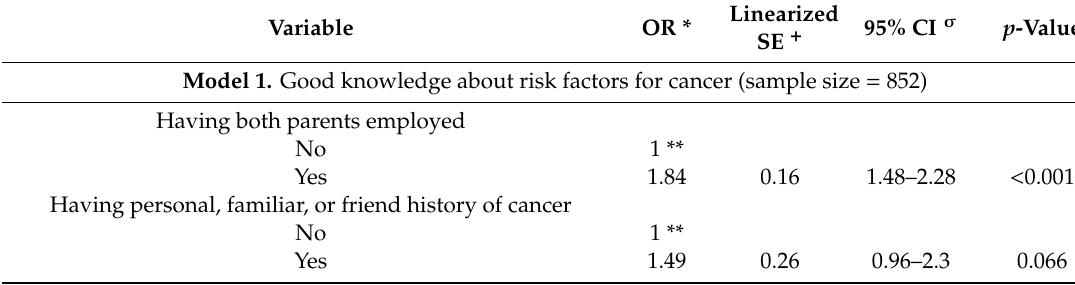
Table 2. Logistic regression models